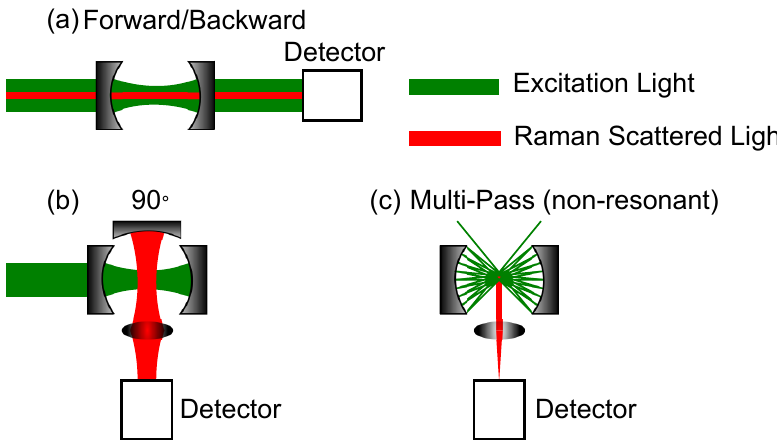
Figure 3. Most common geometries for cavity-enhanced Raman spectroscopy (CERS)-setups. The mirrors’ curvatures can be concave, as well as plane. ( a ) Measurement of Raman scattering in forward or backward direction. ( b ) Measurement of Raman scattering 90 ◦ direction. ( c ) Measurement of Raman scattering using a non-resonant multi-pass cell. The detection is in a 90 ◦ angle.